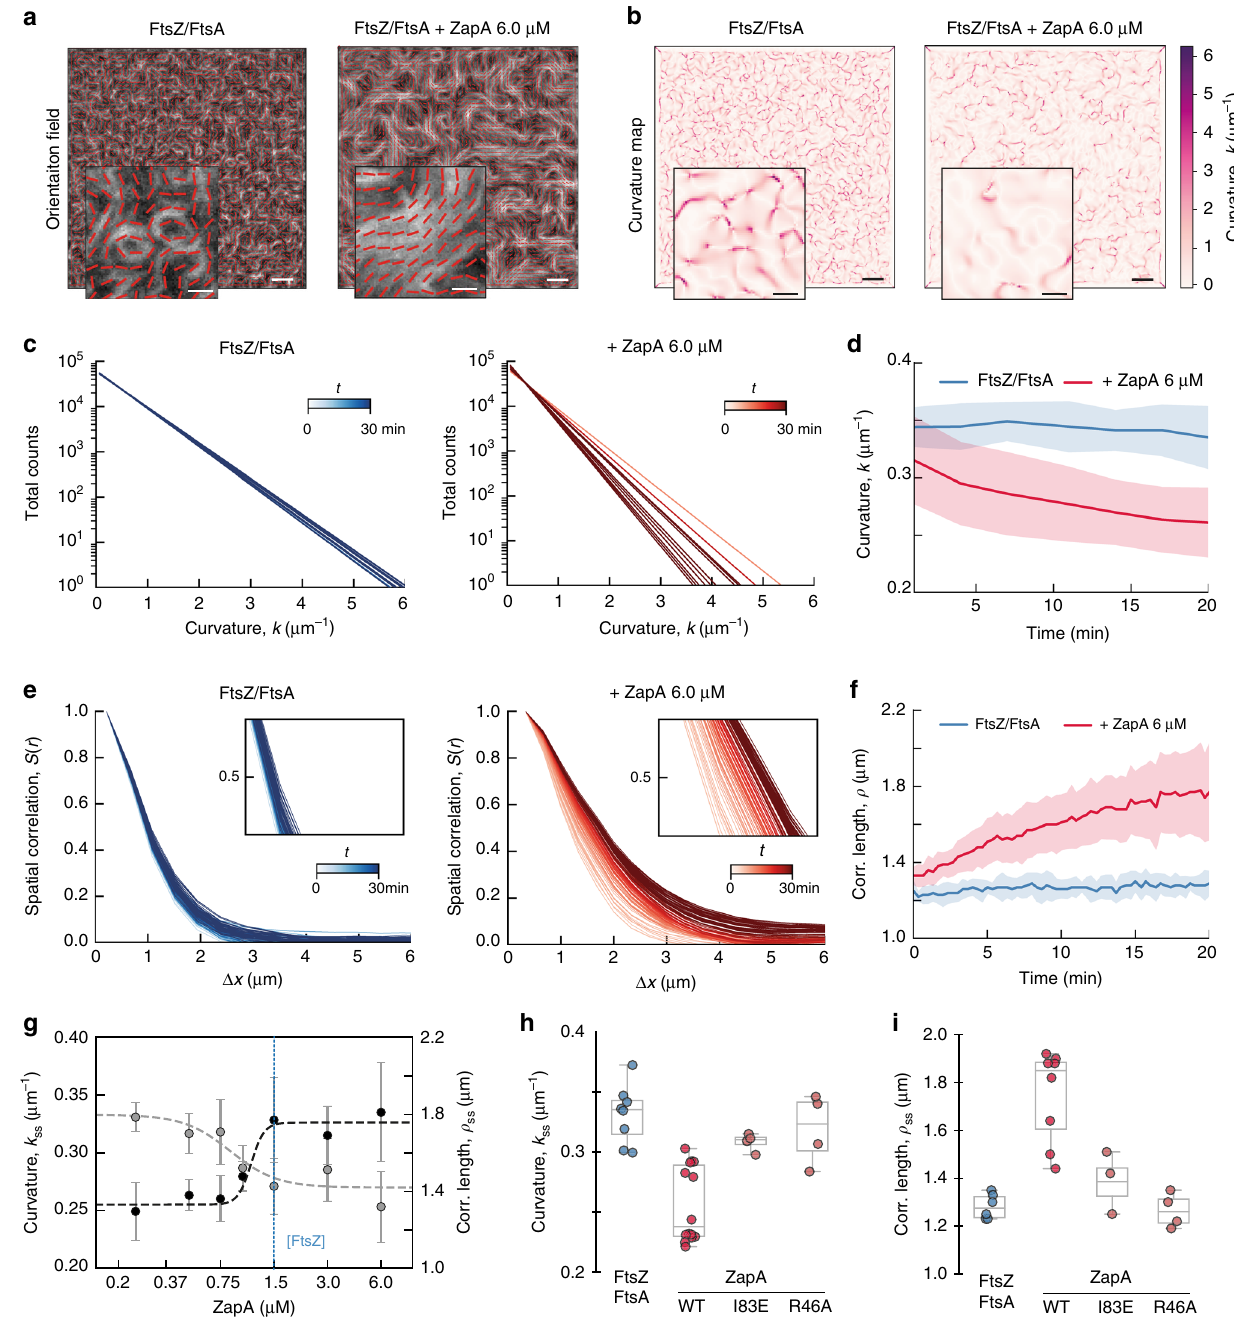
Fig. 2 ZapA changes the architecture of the FtsZ fi lament network. a Orientation fi elds (red lines) for FtsZ fi lament network without (left) or with 6.0 μ M ZapA (right) overlaying corresponding fl uorescence micrographs. b Curvature maps of orientation fi elds; white areas correspond to areas with straight fi lament bundles, while the purple areas corresponds to the degree of curvature. Scale bars: large image, 5 μ m; small image, 2 μ m. c Time-dependent decrease of curvature for FtsZ fi laments alone (left, blue gradient, light to dark) and with 6 μ M ZapA (right, red gradient, light to dark). d The mean curvature, k , at each time point was given by the characteristic length scale of an exponential fi t to the curvature distributions. Curves depict the mean and std as shaded error bands of independent experiments (FtsZ, n = 10, ZapA, n = 10). e Typical spatial correlation function, S( r ), for an FtsZ fi lament network without (left, blue gradient, light to dark) or with 6 μ M ZapA (right, red gradient, light to dark). For FtsZ/FtsA the curves overlapped in time while ZapA promoted a shift to higher correlation lengths. f Correlation length, ρ , was given by the intersection line where S( r ) = 0.5 (insets in e ) and shows that ρ remained constant for FtsZ/FtsA (blue) over time, but continuously increased with 6 μ M ZapA (red). Curves show the mean and std as shaded error bands of independent experiments (FtsZ, n = 6, ZapA, n = 8). g k (gray) and ρ (black) with varying concentrations of ZapA. ZapA induced a switch-like behavior for k ss and ρ ss ( n H = 3.28 and EC50 = 0.84 μ M; n H = 12.04 and EC50 = 1.05, respectively) with a saturation point close to equimolar concentrations with FtsZ. Circles depict the mean and std of independent experiments (FtsZ, n = 6, ZapA, n = 8). The 90% con fi dence intervals for n H and EC50 obtained from boostrapping are shown in Supplementary Table 2. h , i Mean values for ZapA I83E and R46A (light red) shows different behavior compared to wildtype ZapA (red). Source data available at Figshare [https://doi.org/10.6084/m9. fi gshare.10347062.v1].